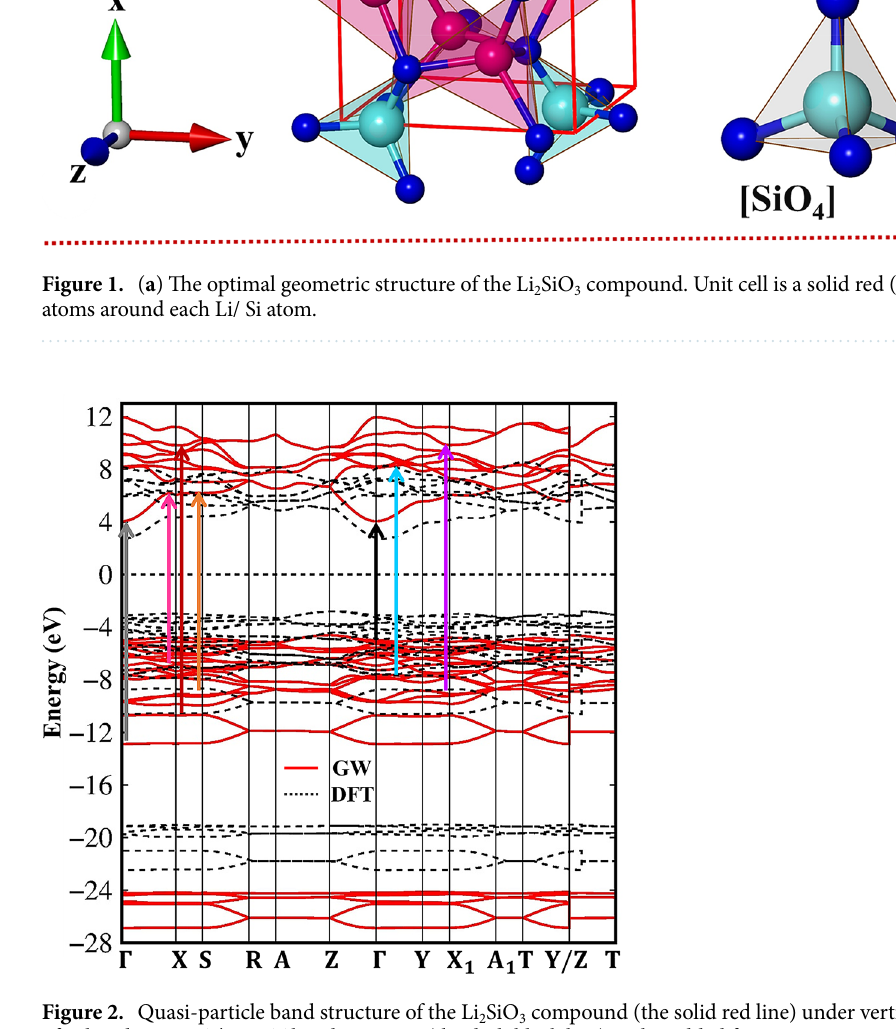
Figure 2. Quasi-particle band structure of the Li 2 SiO 3 compound (the solid red line) under vertical excitations of colored arrows. The DFT band structure (the dash black line) is also added for